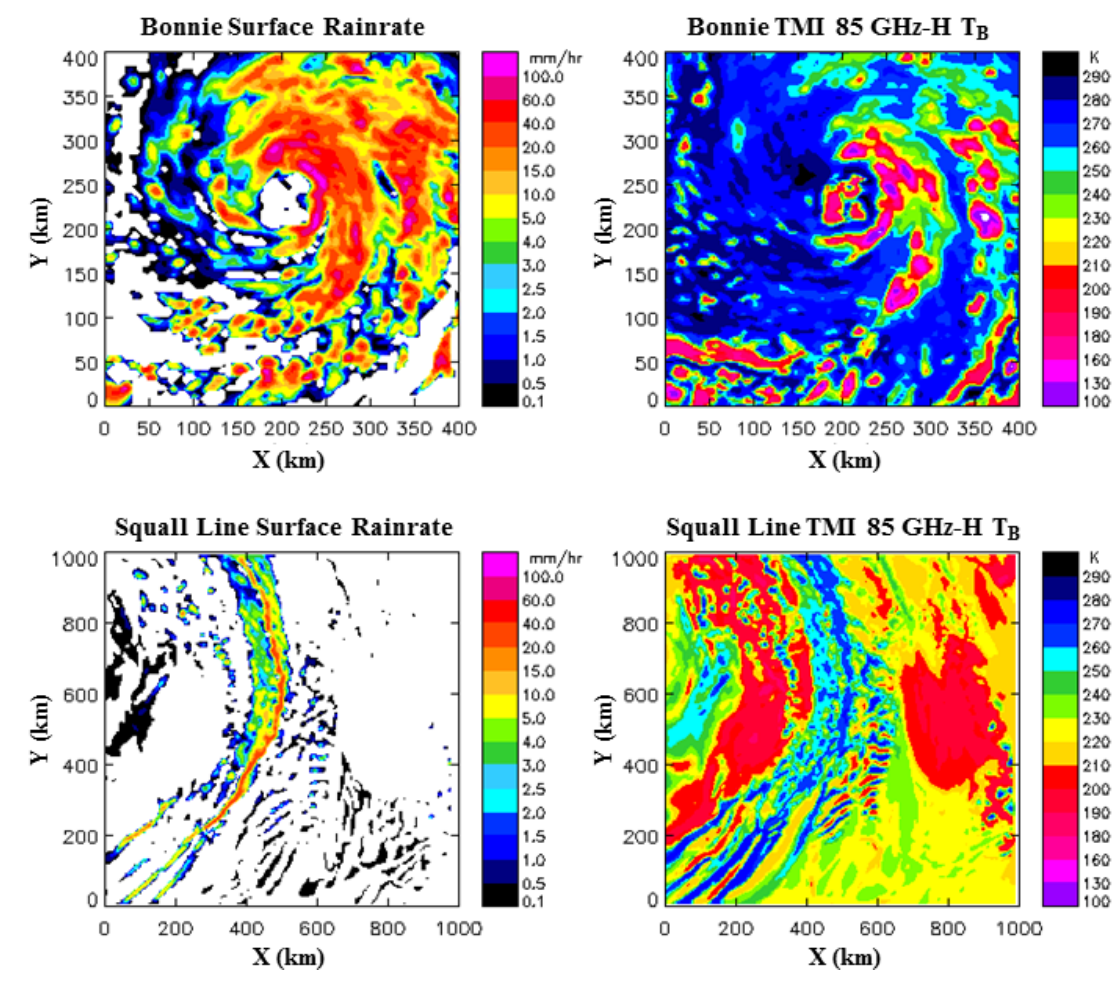
Figure 3. Surface rainrate (mm·hr − 1 ) and simulated T MM5 simulation for hurricane Bonnie (top panel) and Goddard Cumulus Ensemble (GCE) simulation for squall line (bottom